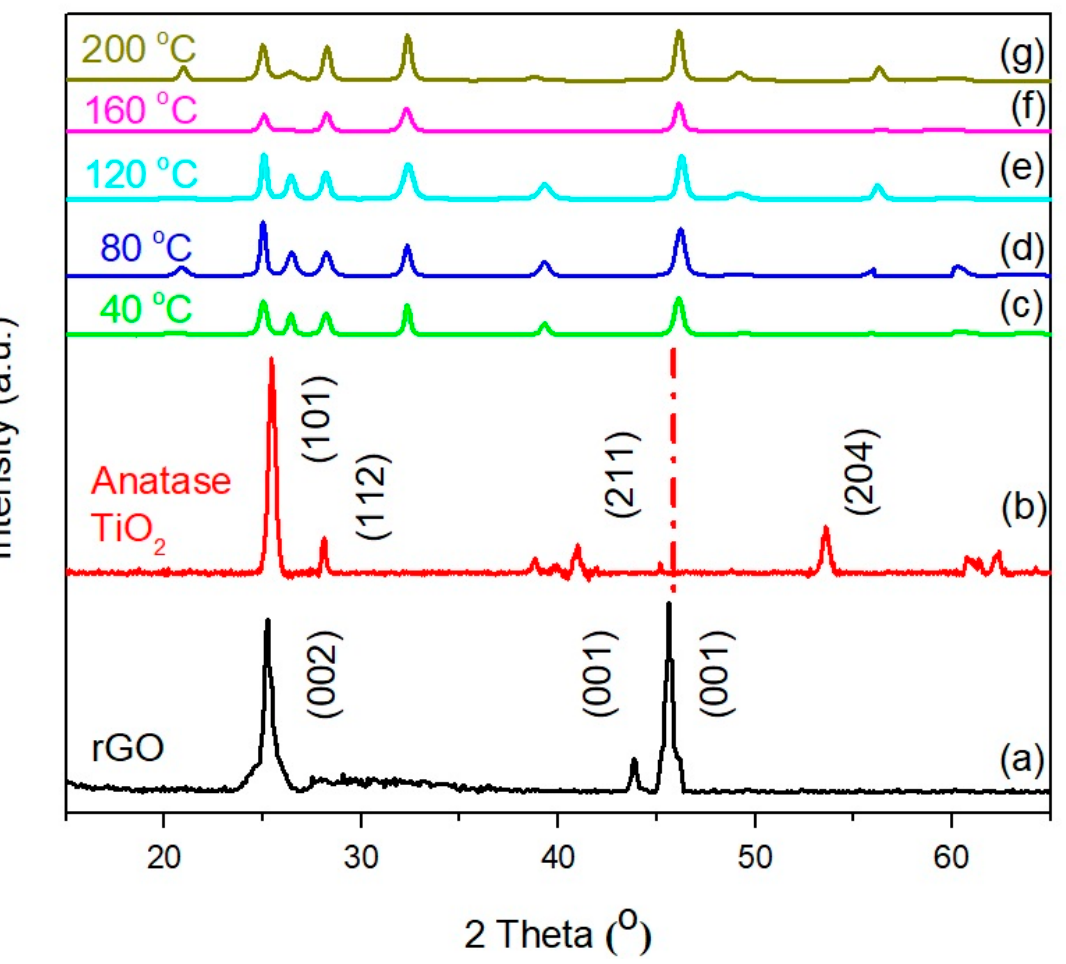
Figure 9. XRD patterns of ( a ) rGO, ( b ) anatase TiO 2 , rGO-TiO 2 nanocomposite deposited at temperature of ( c ) 40 °C, ( d ) 80 °C, ( e ) 120 °C, ( f ) 160 °C, and ( g ) 200 °C.